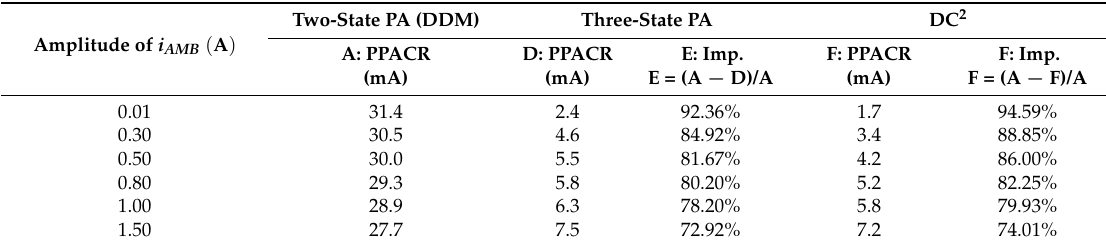
Table 3. Peak-to-peak amplitudes of current